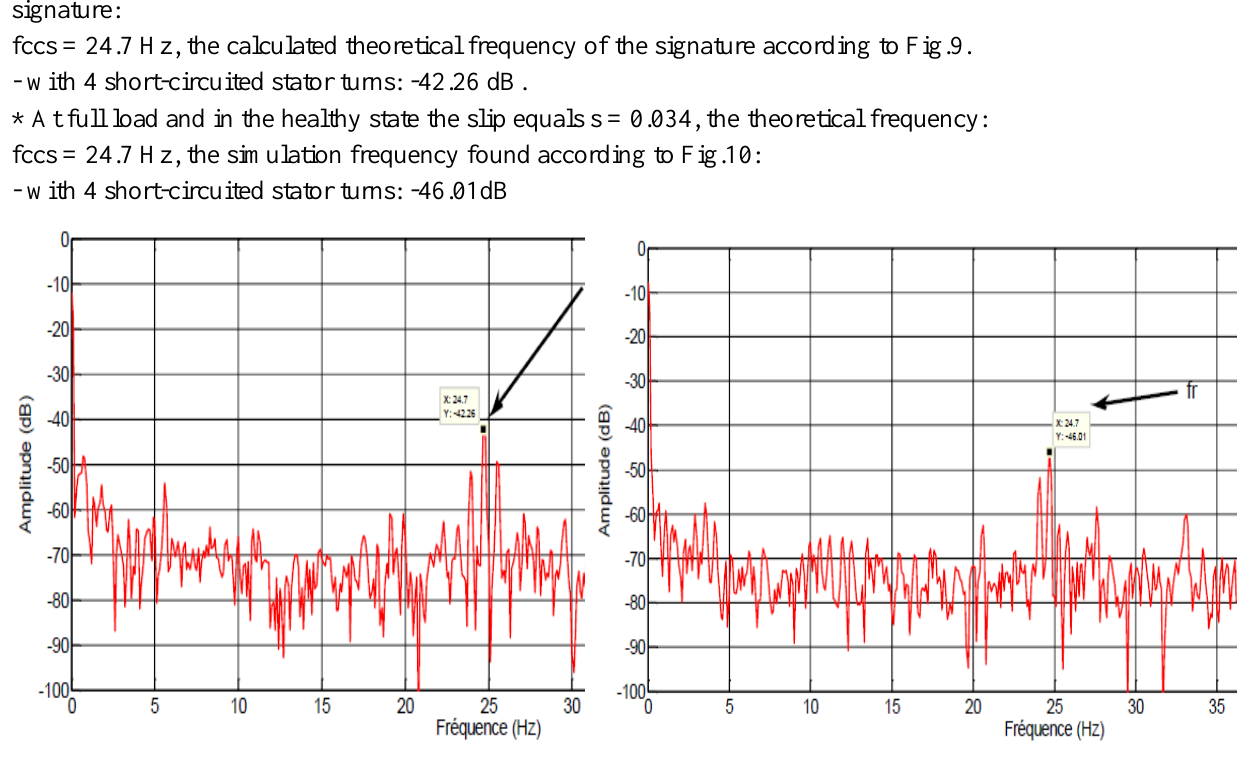
Figure 9. Experimental logarithmic spectrum of the HPVPA of a motor with 4 short-circuited stator turns at low load